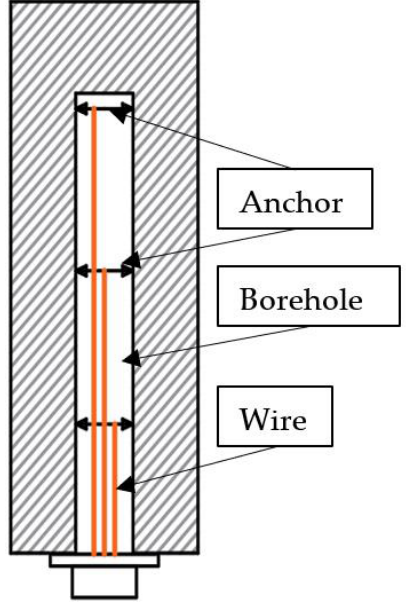
Figure 9. Scheme of the three point extensometer.